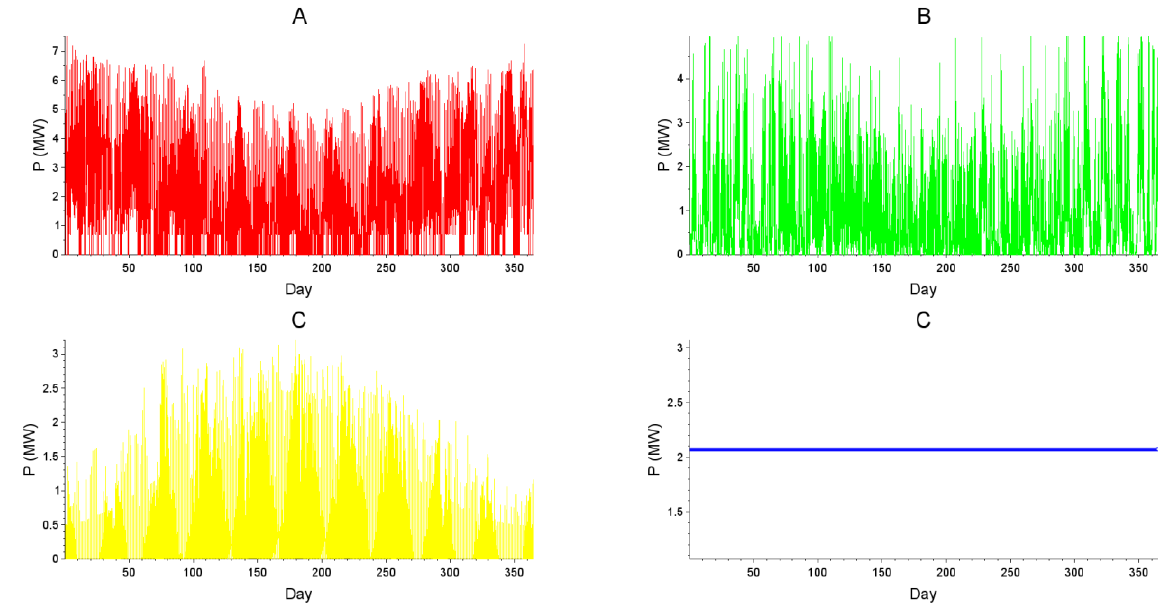
Figure 7. Generation of electrical power in ( A ) GT, ( B ) WT, and ( C ) PV. ( D ) power consumption from the grid for RES nominal power equal to 10 MW.